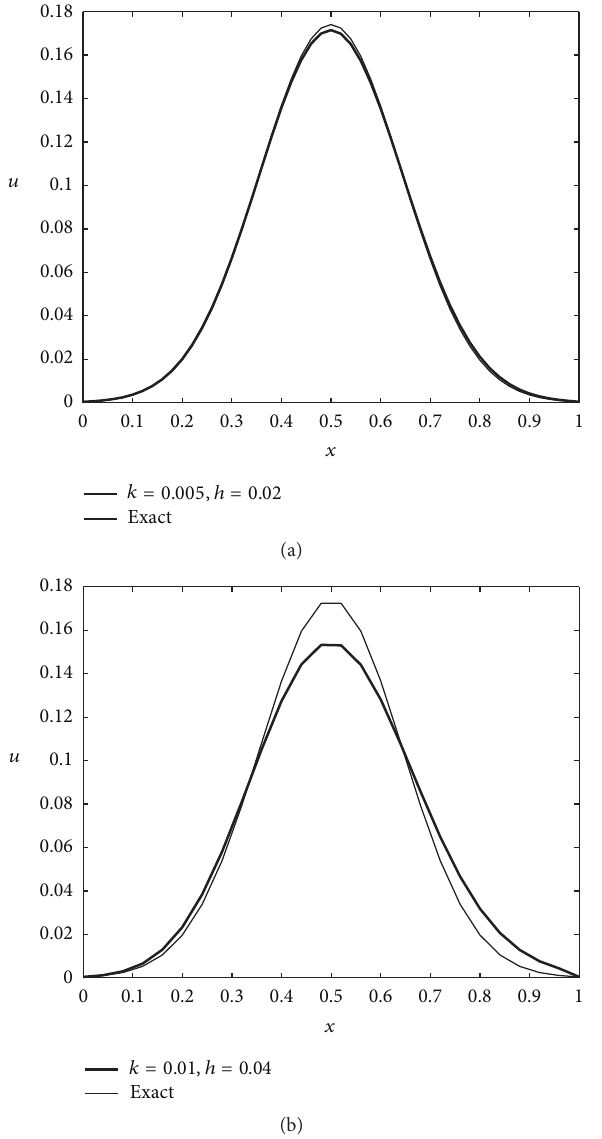
Figure 7: Comparison of numerical results with exact results using NSFD scheme at some values of 𝑘 and ℎ .